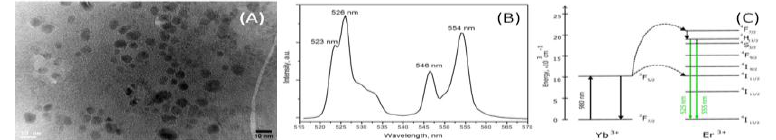
Fig. 1. (A) TEM image of the synthesized upconversion nanoparticles; (B) fluorescence spectrum; (C) energy transfer in upconversion